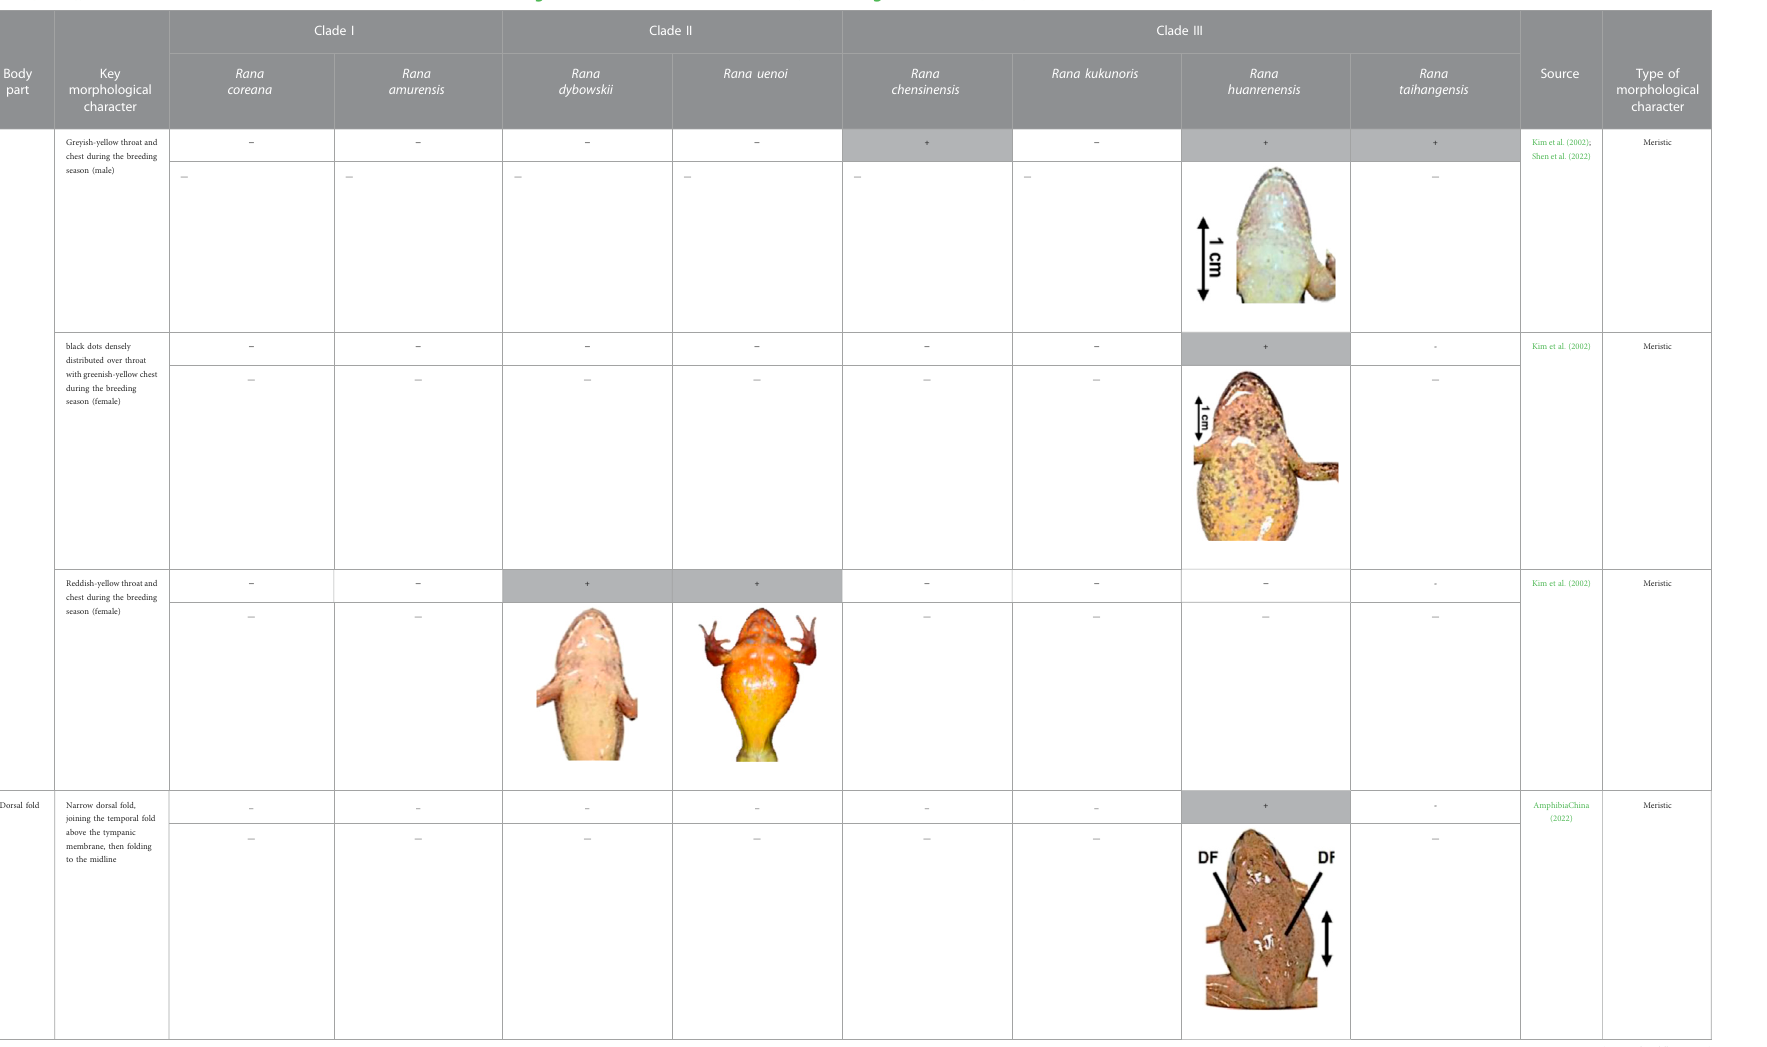
boxes marked with symbol ( − ) indicate the absence of the character in the species, OR, the absence of de fi nitive information but matching with at least a few individuals of the species. The symbol (?) indicate the lack of information about the speci fi c morphological character. Coloration outside of the breeding season is not speci fi ed as the trade is limited to the breeding season when body condition makes frogs more suitable for human consumption. The comparison of morphological characters and classi fi cations of Rana into clades I, II and III in the table are adapted from the operational taxonomic units (OTU) based on the 16S rRNA phylogeny of Othman et al. (2022), where R. chensinensis matches with OTU 7 and R. taihangensis matches with OTU 1 and 2, following Shen et al.